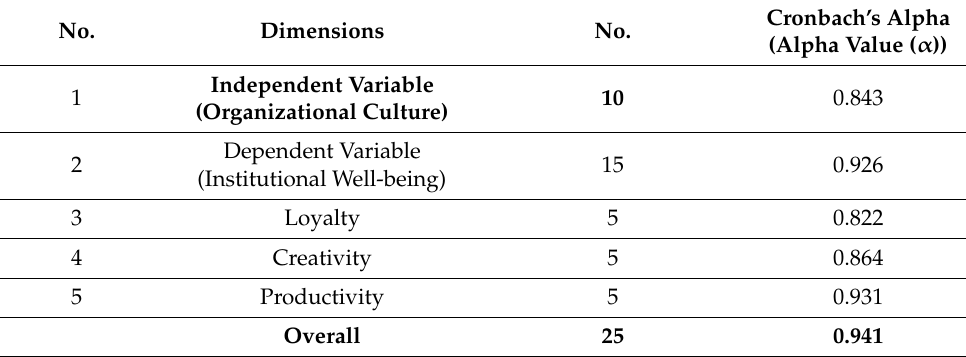
Table 3. Reliability test (Cronbach’s alpha) for all variables.